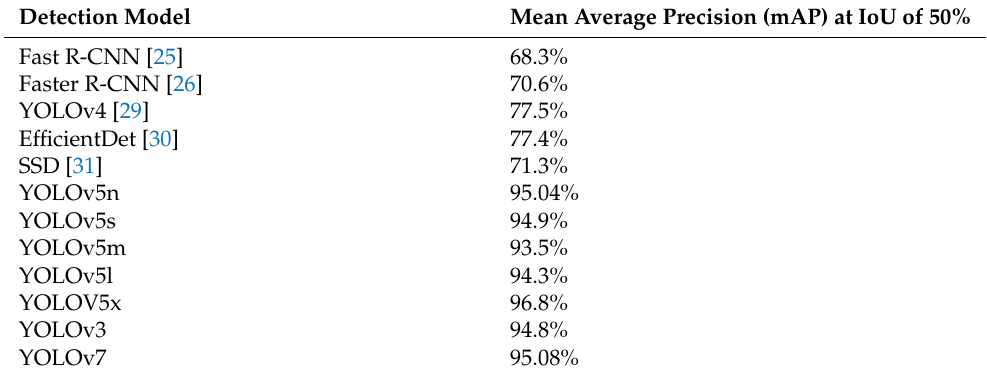
Table 6. Performance of YOLOv3, YOLOv5, and YOLOv7 compared to prior models. Detection